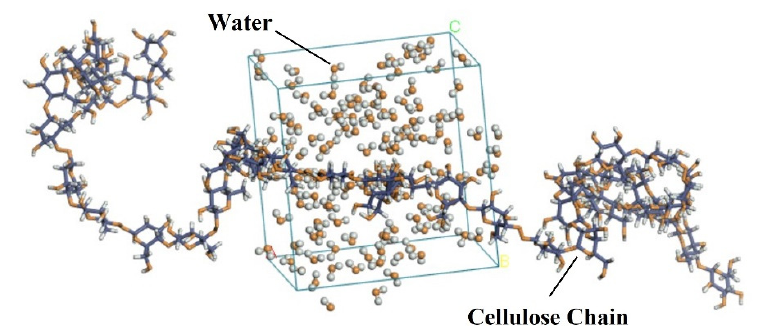
Figure 1. Water–cellulose composite model.